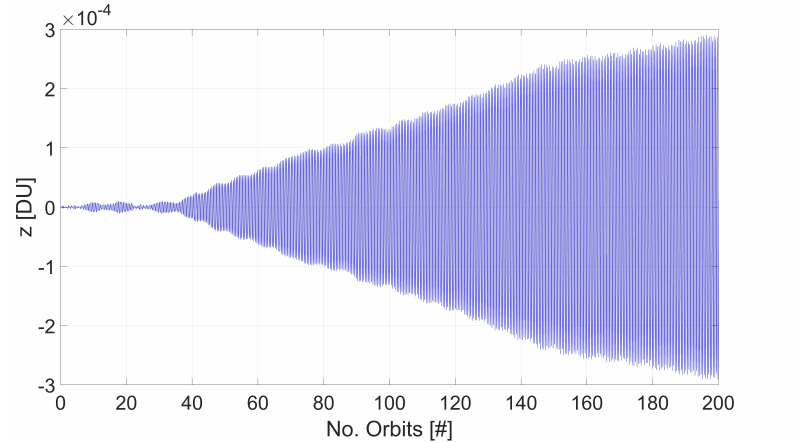
Figure 5. Behavior of a vertical oscillator determined neglecting order three